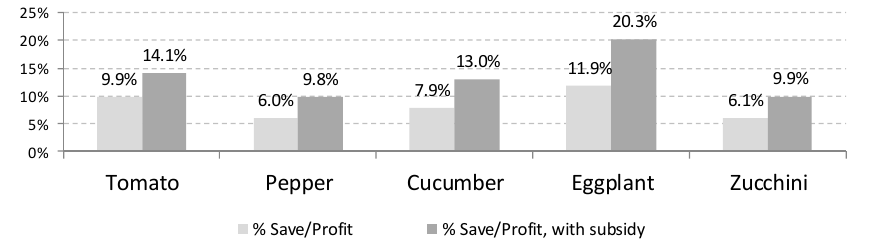
Figure 10. Savings % according to the profit of each crop.